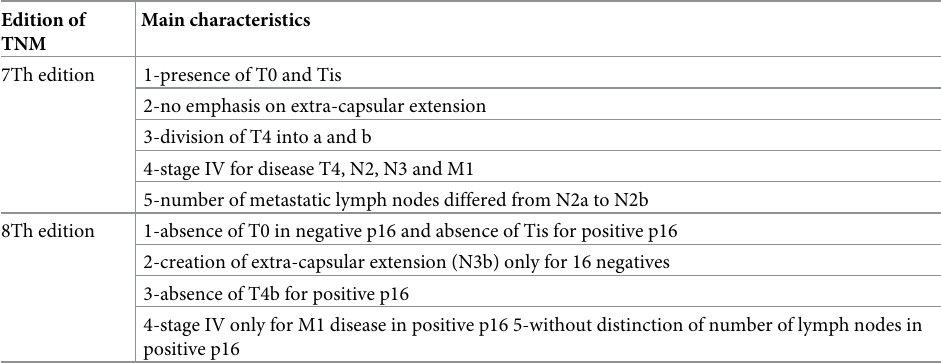
Table 4. Major changes from the seventh to the eighth editions of TNM